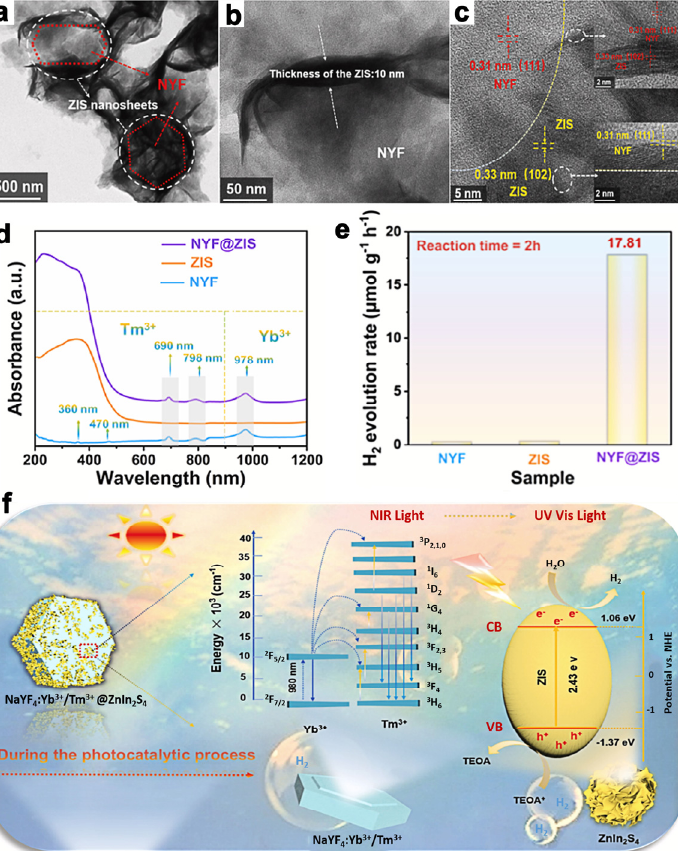
Figure 4. ( a , b ) TEM and ( c ) HRTEM images of NYF@ ZnIn 2 S 4 composite. ( d ) UV − vis − NIR absorption spectra of ZnIn 2 S 4 , NYF and NYF@ ZnIn 2 S 4 composite. ( e ) Time − dependent photocatalytic hydrogen production curves and hydrogen evolution rates of ZnIn 2 S 4 , NYF, and NYF@ZnIn 2 S 4 composite under NIR ( λ > 800 nm) light irradiation. ( f ) Mechanism of photocatalytic H 2 evolution for NYF@ ZnIn 2 S 4 materials under NIR light illumination. Reprinted with permission from Ref. [55]. Copyright 2022, Elsevier.